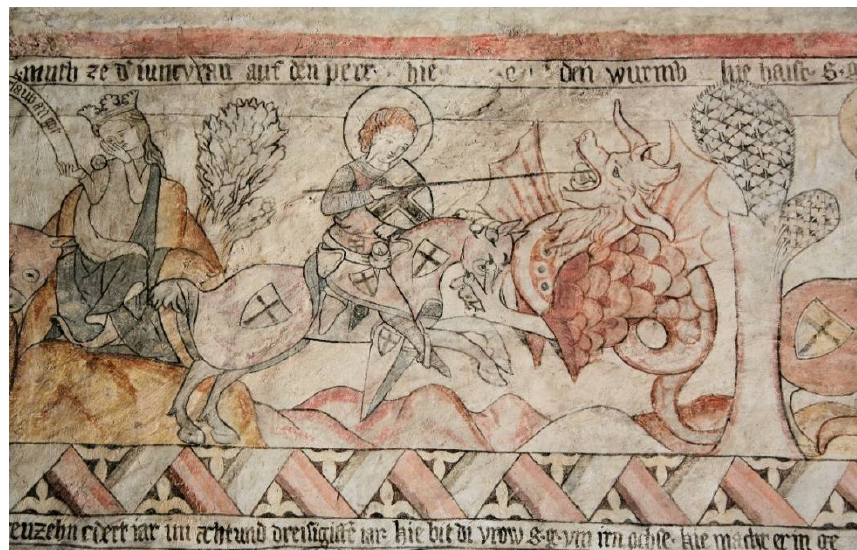
Figure 23. Jindřichův Hradec, castle. St. George’s cycle, detail of St. George fighting the dragon, with inscription identifying the patron of the paintings and their dating to 1338 in the lower part. Photo by František Záruba, the author’s own work.